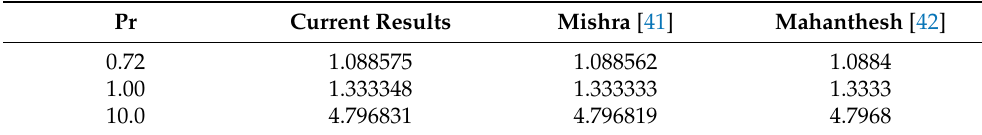
Table 1. Comparison of the current results with already published papers.